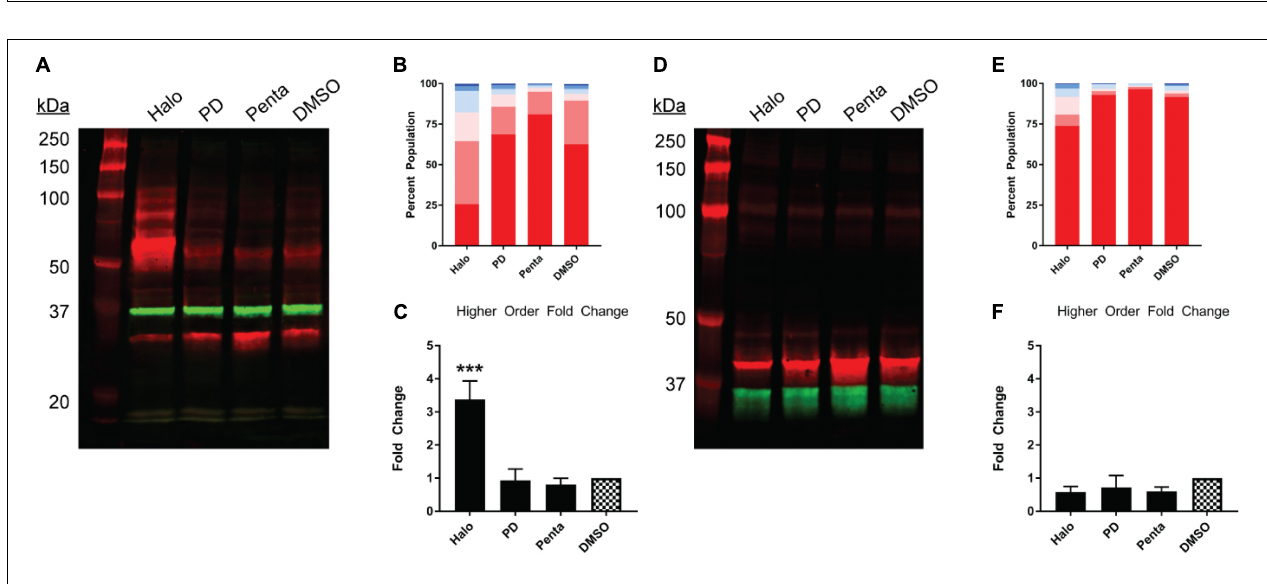
FIGURE 4 | Pharmacological effects on SDS-PAGE mobility of the N-terminally tagged σ 1R constructs. Results for the N-terminally myc-tagged (A–C) , and N-terminally Nluc-tagged (D–F) constructs are shown. (A , D) Red bands are visualized by anti-myc (A) or anti- σ 1R (D) and green bands are visualized by anti-GAPDH (A,D) antibodies on 10% SDS-PAGE (protein standard, haloperidol, PD 144418, (+)-pentazocine, DMSO vehicle). (B , E) Quantification of band intensities normalized to total signals within each lane for myc (B) and σ 1R (E) blots. (C , F) Pharmacological changes in higher order densities corresponding to tetramers and above bands normalized to DMSO vehicle (haloperidol, PD 144418, (+)-pentazocine, DMSO vehicle). Each blot image is representative of n > 3 experiments that are averaged in bar graphs. One-way ANOVA followed by post hoc Tukey analysis ( ∗∗∗ p <